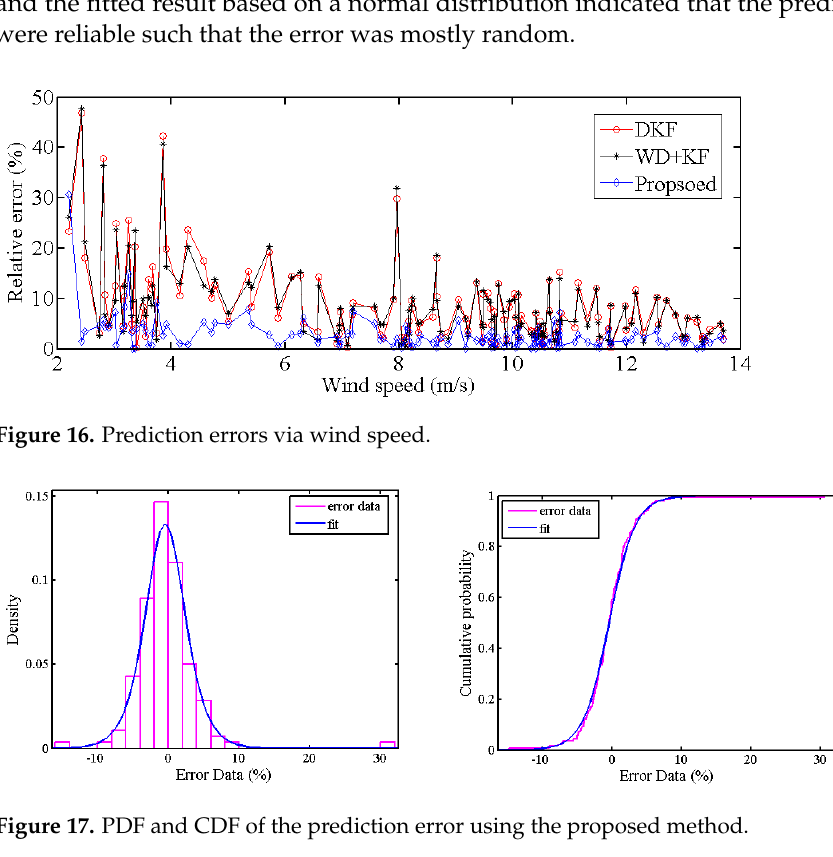
Figure 15. Prediction errors from the different methods.